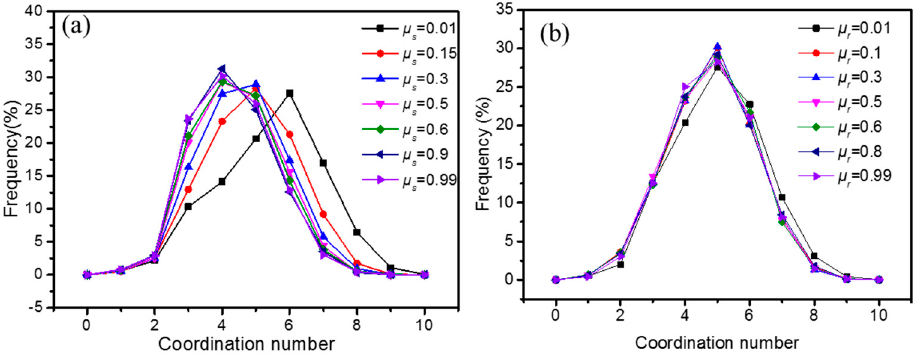
Figure 11. BPD of the pellet pile and the inserted graph is the average porosity (the average value of seven points on a curve) with different ( a ) static and ( b ) rolling friction coefficients.